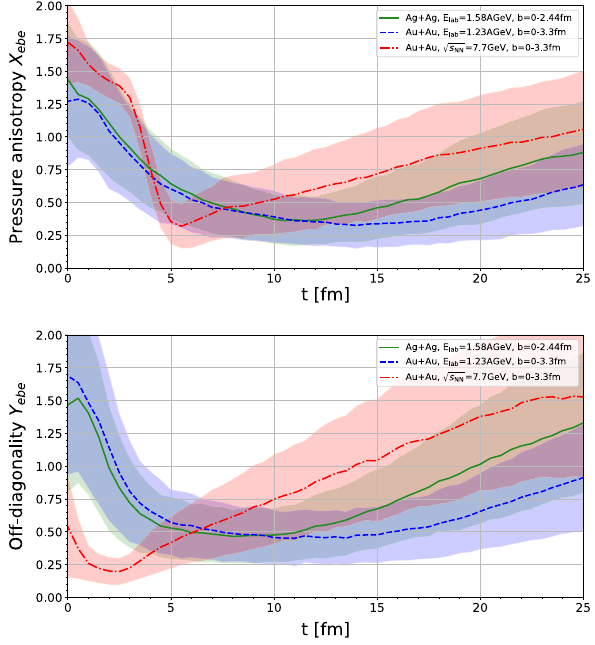
Fig. 10 Time evolution of X ebe and Y ebe in the center of the system for central Ag+Ag at E lab = 1.58 AGeV, Au+Au at E lab = 1.23 AGeV √ s NN = 7.7 GeV collisions. The colored error bands and Au+Au at correspond to the standard